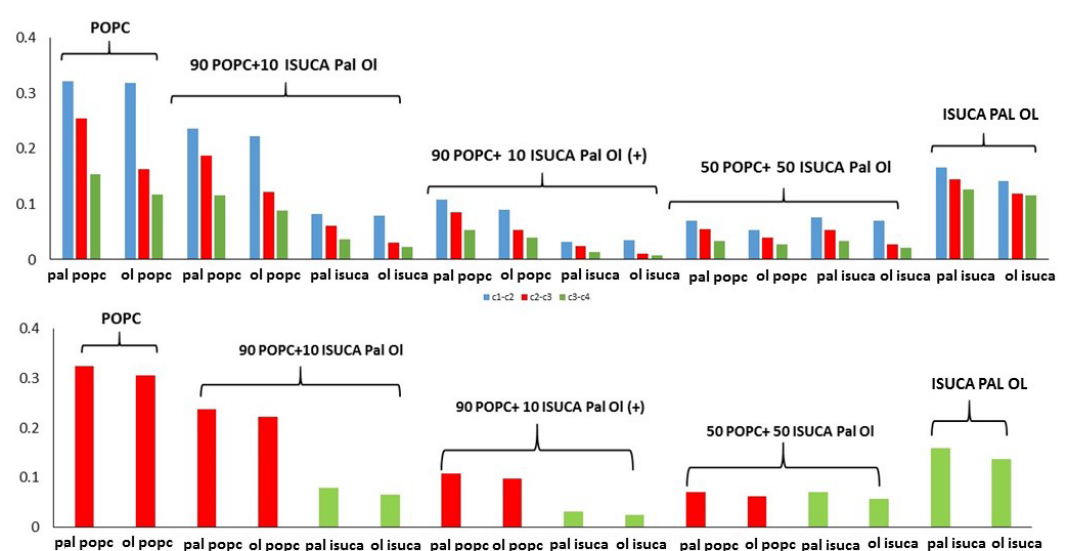
Figure 10. P 2t ( top ) and P 2b ( bottom ) for POPC/ISUCA Pal Ol mixtures of varying composition. As expected, both P 2t and P 2b parameters decrease when the ISUCA-derived lipid concentration increases (0% > 10% > 50%). What is worth noting is the effect of protonation (marked with a plus sign in Figure 10). A noticeable reduction in both the P 2t and P 2b parameters is observed (compare values for protonated and unprotonated 90 POPC + 10 ISUCA Pal Ol bilayers), which indicates a less-ordered structure in the protonated case.